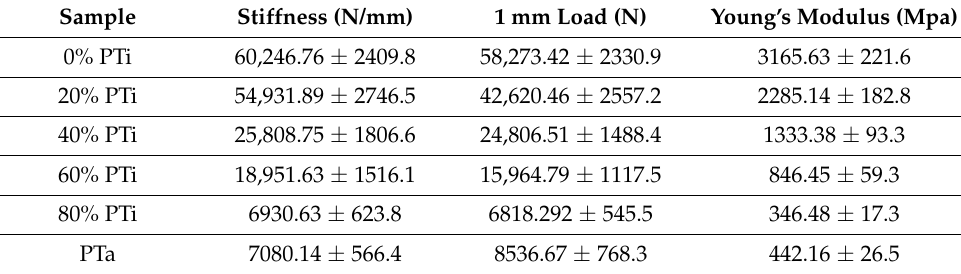
Table 2. Mechanical compression test of various porous